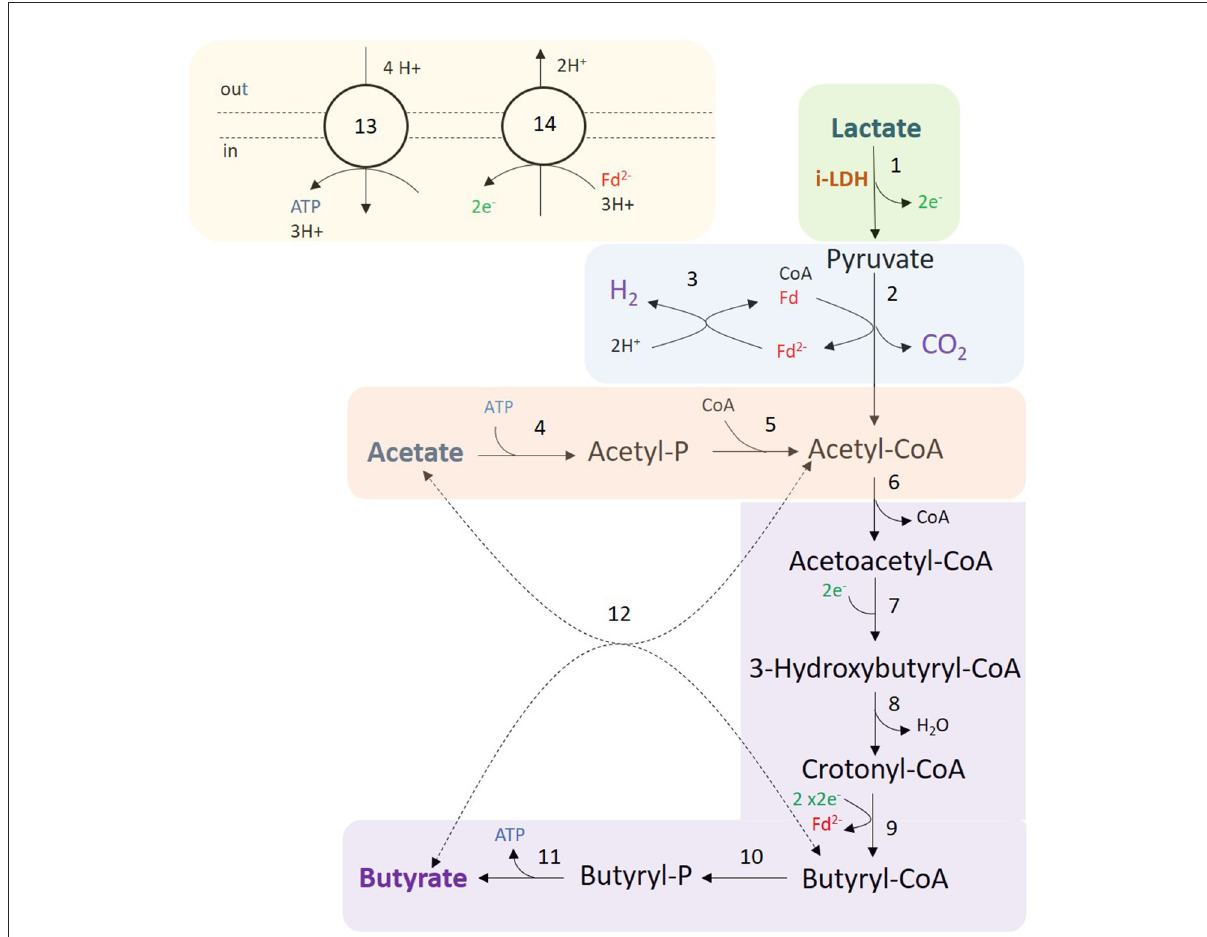
FIGURE5 Fermentation of lactate and acetate by C. beijerinckii . Colored areas correspond to the following modules: lactate oxidation (green); H 2 , CO 2 , and acetyl-CoA production (blue); acetate consumption (red); butyrate production (purple); and redox cofactor regeneration, and ATPase (yellow). Numbers in reactions correspond to the following enzymes and reaction identifiers in the model: 1, NAD-independent L -lactate dehydrogenase (LDH_L); 2, pyruvate:ferredoxin oxidoreductase (POR4); 3, Ferredoxin hydrogenase (FDXNH); 4, acetate kinase (ACK); 5, phosphate acetyltransferase (PTA); 6, Acetoacetyl-CoA thiolase (ACACT1); 7, ( S )-3-Hydroxybutanoyl-CoA:NAD + oxidoreductase or NAD(P)-dependent acetoacetyl-CoA reductase (HACD1x or HACD1y); 8, 3-hydroxybutyryl-CoA dehydratase (3HBCD); 9, Butyryl-CoA dehydrogenase/electron-transferring flavoprotein complex (Bcd-EtfAB) (ACOAD1); 10, Butanoyl-CoA:phosphate butanoyltransferase (BCOPBT); 11, Butyrate kinase (BUTK); 12, Butyryl-CoA-acetoacetate CoA-transferase (COAT2); 13, ATPase (ATPase); 14, Na + -translocating ferredoxin:NAD + oxidoreductase complex (Rnf). Dashed lines (reaction 12) indicate that the reaction might not be the main